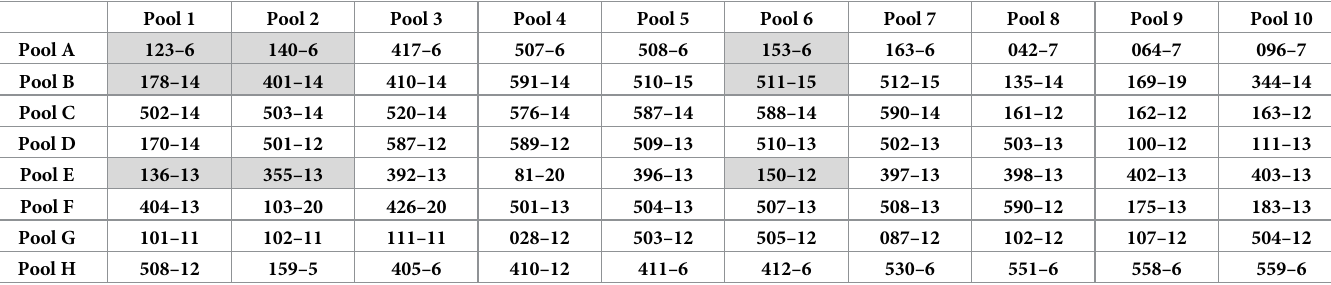
Table 6. Double-entry chart with analyzed samples (example of a real